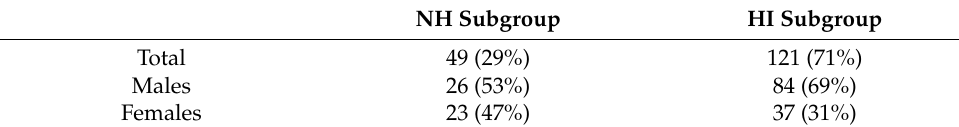
Table 2. Demographic characteristics of subjects in NH and HI subgroups.